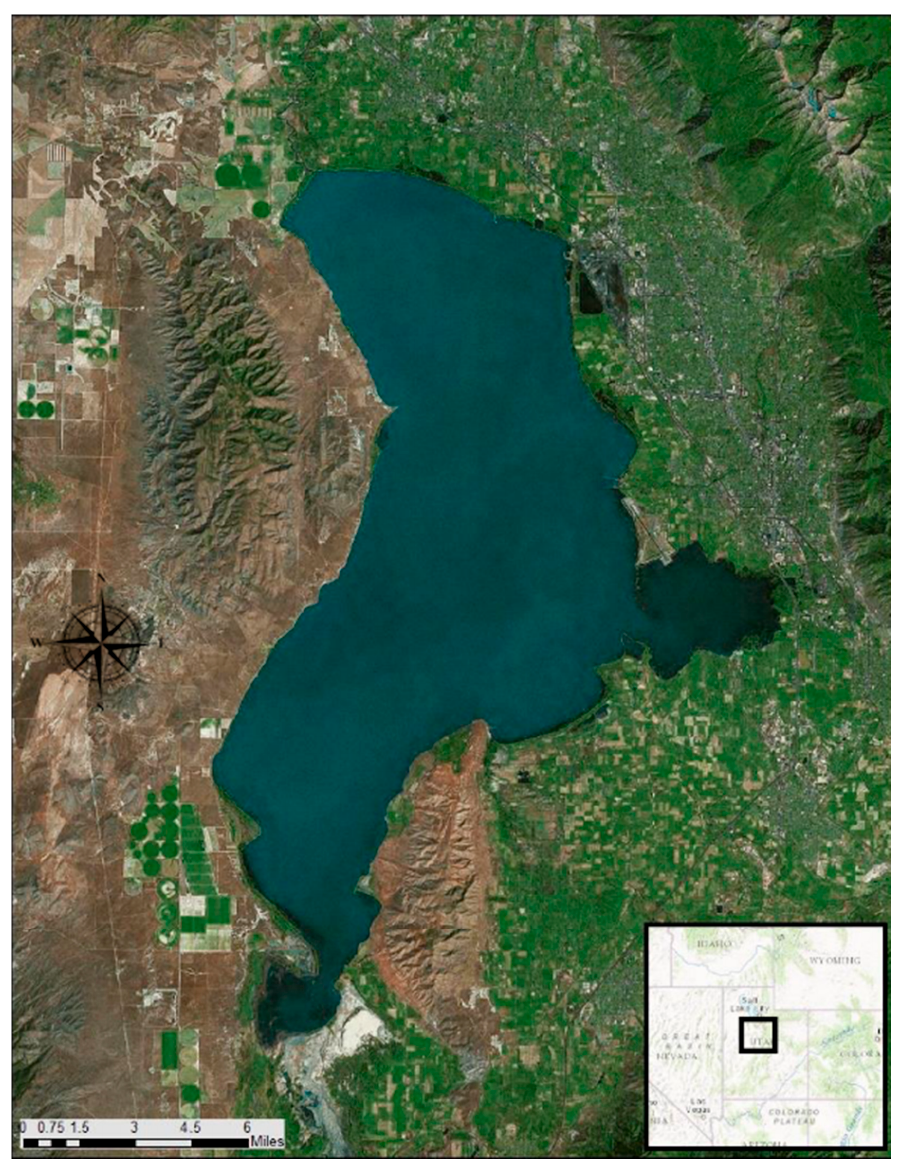
Figure 1. Utah Lake located in northern Utah and is a large, freshwater lake with a surface area